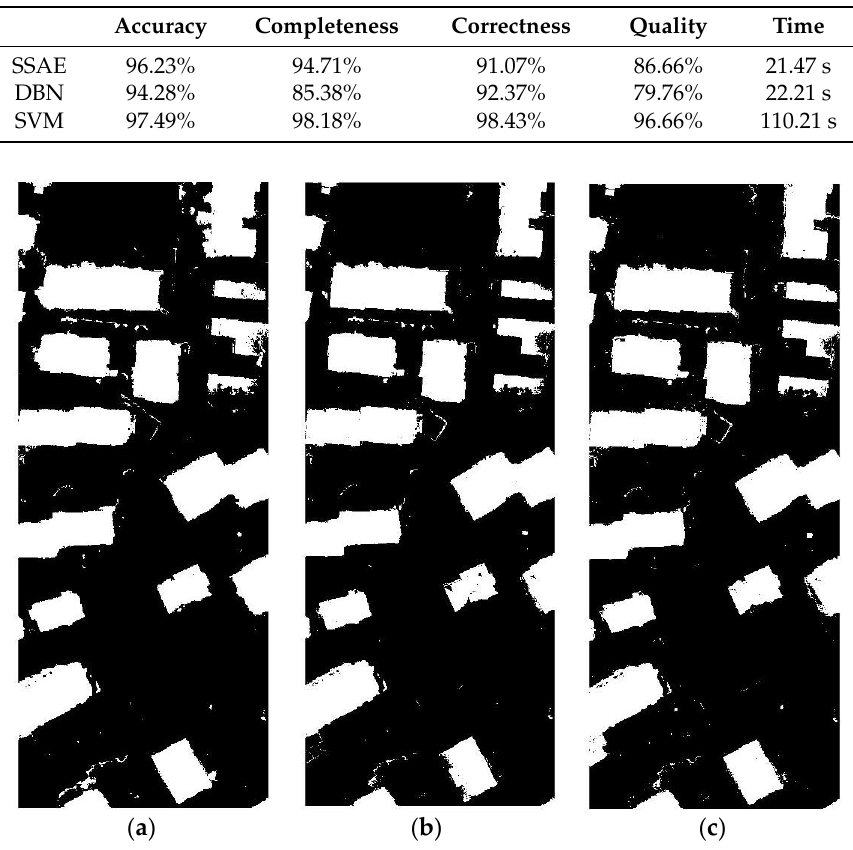
Figure 12. The result of Area 34: ( a ) the result of DBN; ( b ) the result of SSAE; and ( c ) the result of SVM.